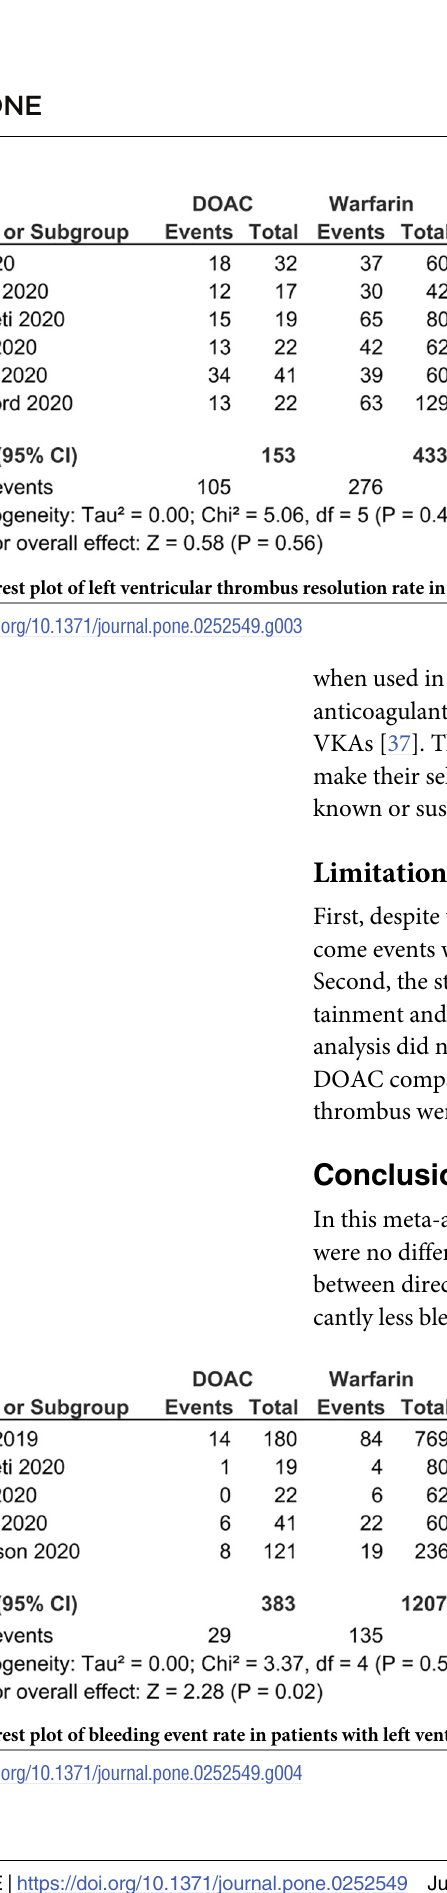
PLOS ONE | https://doi.org/10.1371/journal.pone.0252549 June 4,